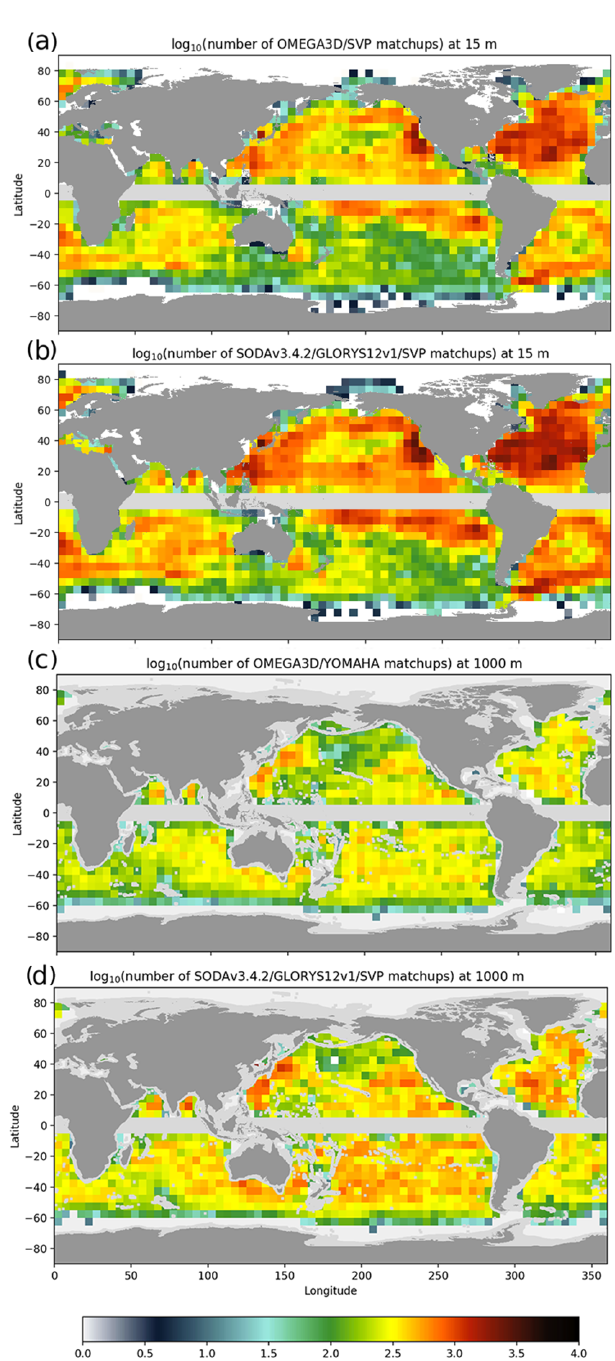
Figure 3. Number of matchups within 5 ◦ × 5 ◦ bins between OMEGA3D (a) as well as GLORYS12v1 and SODAv3.4.2 (b) velocities (at 15m depth) and SVP observations and between OMEGA3D (c) as well as GLORYS12v1 and SODAv3.4.2 (d) ve- locities (at 1000m) depth and YOMAHA